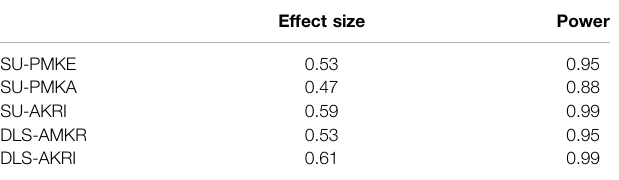
TABLE 4 | Post-hoc power analysis on the correlation between Core-related measurements and knee kinetic and kinematic measurements Effect size